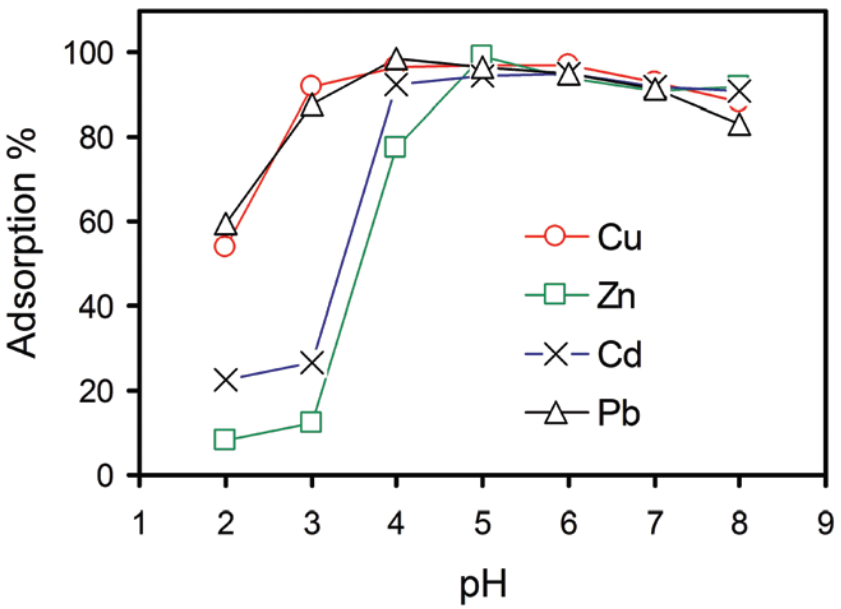
Figure 4. Influence of pH on the adsorption of metal ions on GO. (Adapted with permission from ref. [69]. Copyright 2013 RCS publishing.)